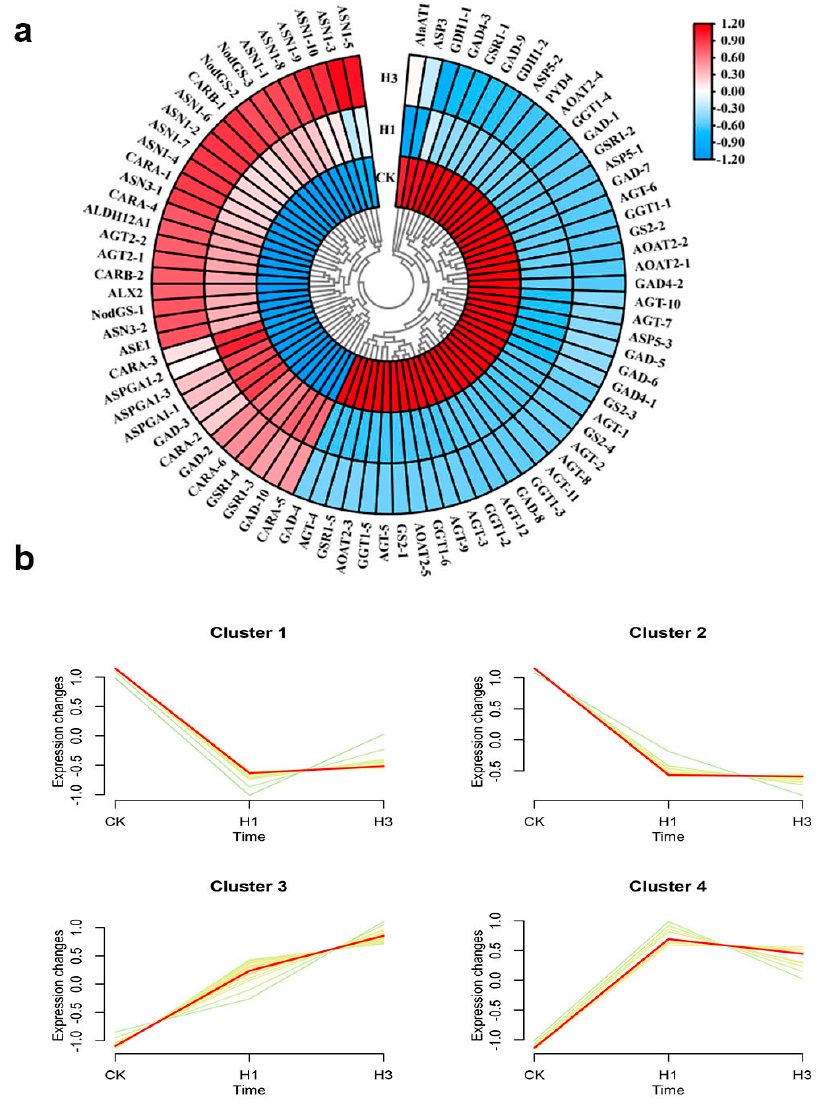
Figure 11. DEGs related to alanine, aspartate, and glutamate metabolism. ( a ) Hierarchical clustering of expression profile of DEGs, ( b ) K-means cluster analysis of DEGs.